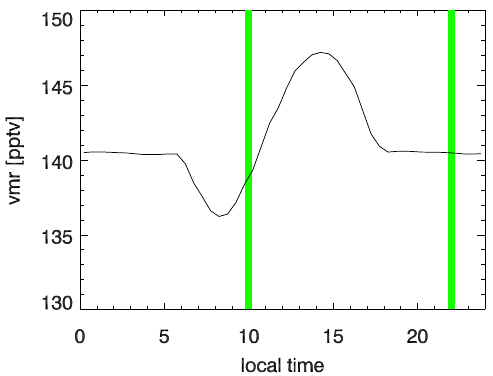
Fig. 12. Diurnal cycle of H 2 O 2 vmr in KASIMA in dependency of local time in 30km; vmr is averaged for the whole data period between 10 ◦ N and 10 ◦ S; The vertical lines mark MIPAS measure- ment